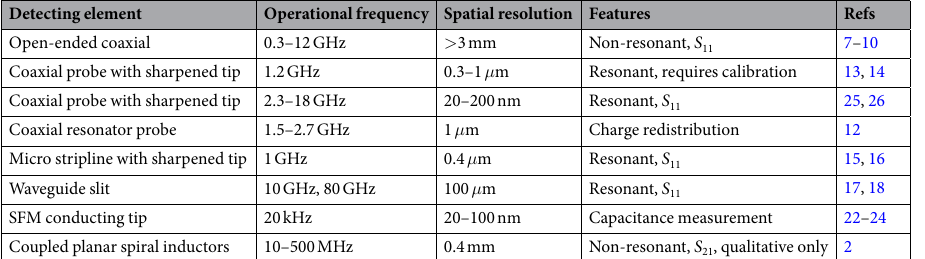
Table 1. Summary of dielectric surface imaging